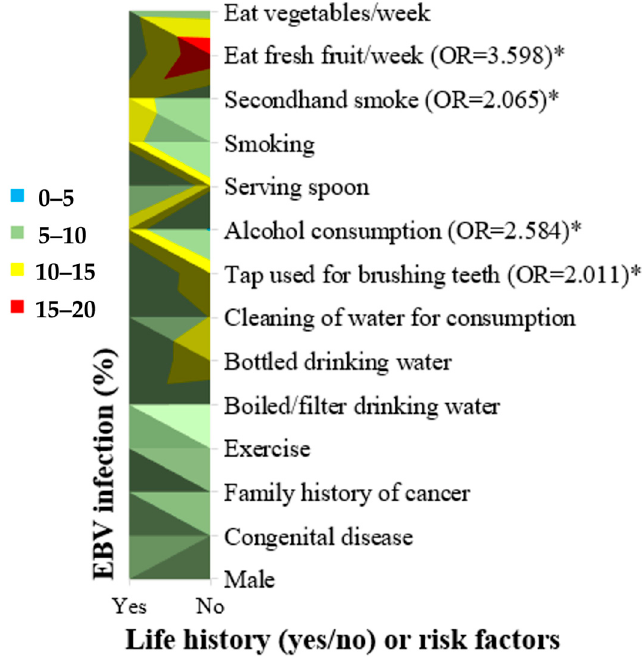
Figure 3. Life history (yes/no) and risk factors for EBV infection (%) in blood based on the three methods. The color represents the percentage of exposure to environmental risk factors: 0–5%, blue; 5–10%, green; 10–15%, yellow; and 15–20%, red. Male, congenital disease, family cancer history, exercise, and boiled/filtered drinking water were not risk factors for EBV DNA detection in blood. Not using tap water for brushing teeth, alcohol consumption, secondhand smoke exposure, and not eating fresh fruit weekly were risk factor factors for EBV DNA detection in blood. Note: not using tap water for brushing teeth reflects the use of other water sources, such as rain/artesian water. Key: *, statistically significant ( p < 0.05).